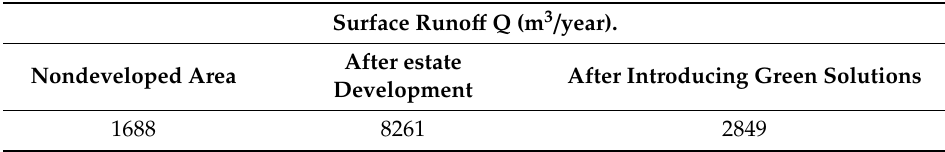
Table 13. Data summary of surface runo ff value before and after the estate development, and after introducing green solutions.